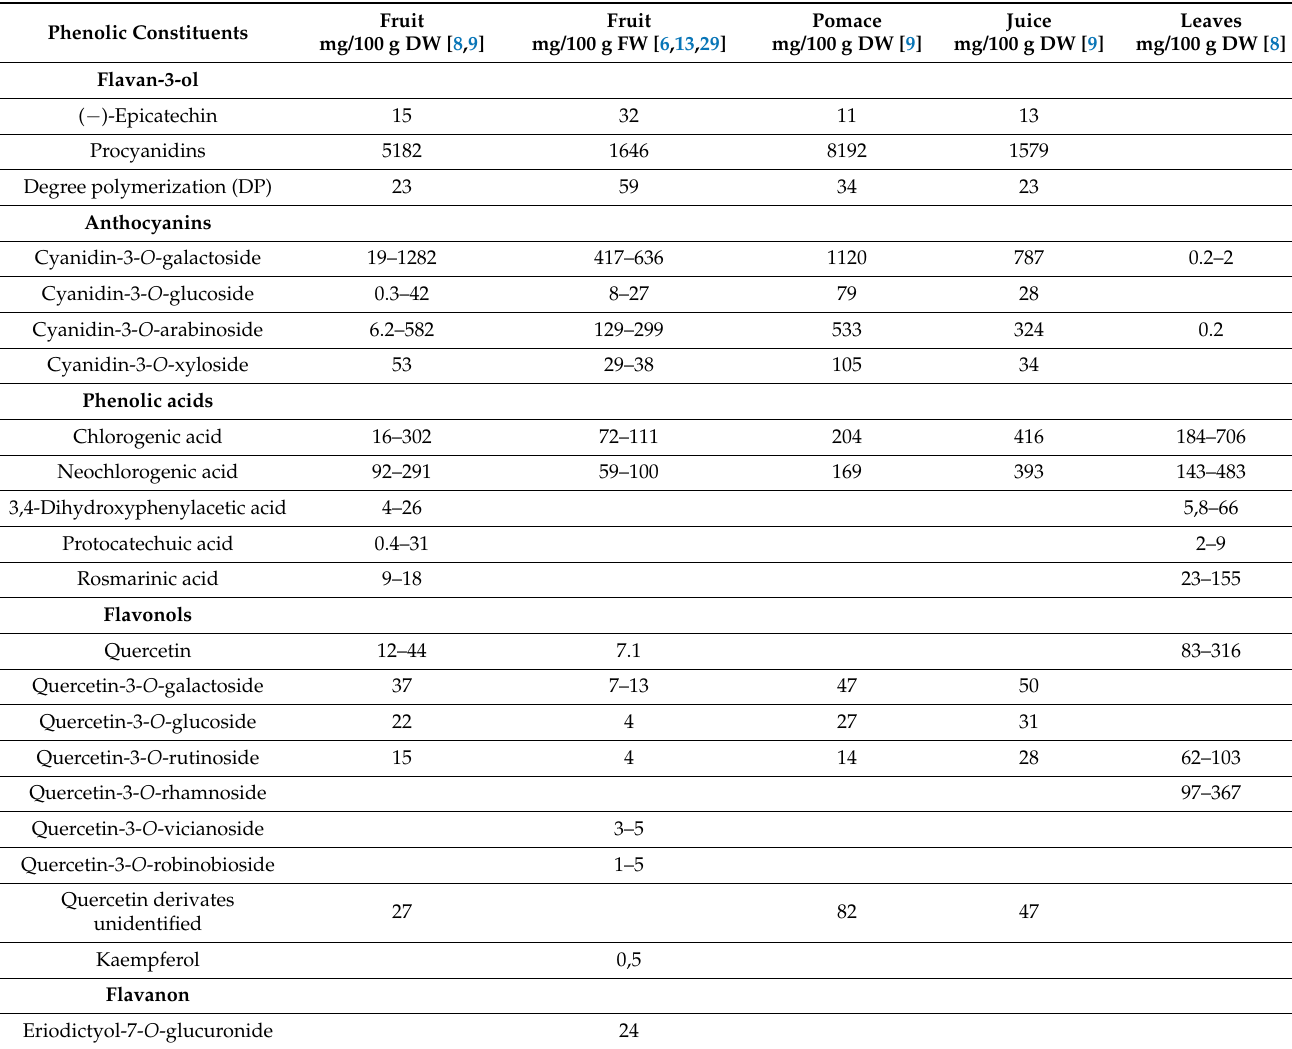
Table 4. Phenolic phytochemicals present in Aronia fruit, pomace, juice and